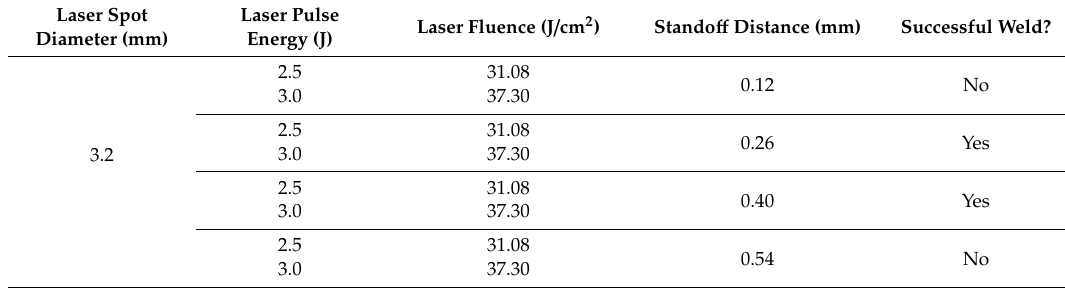
Table 5. List of experimental